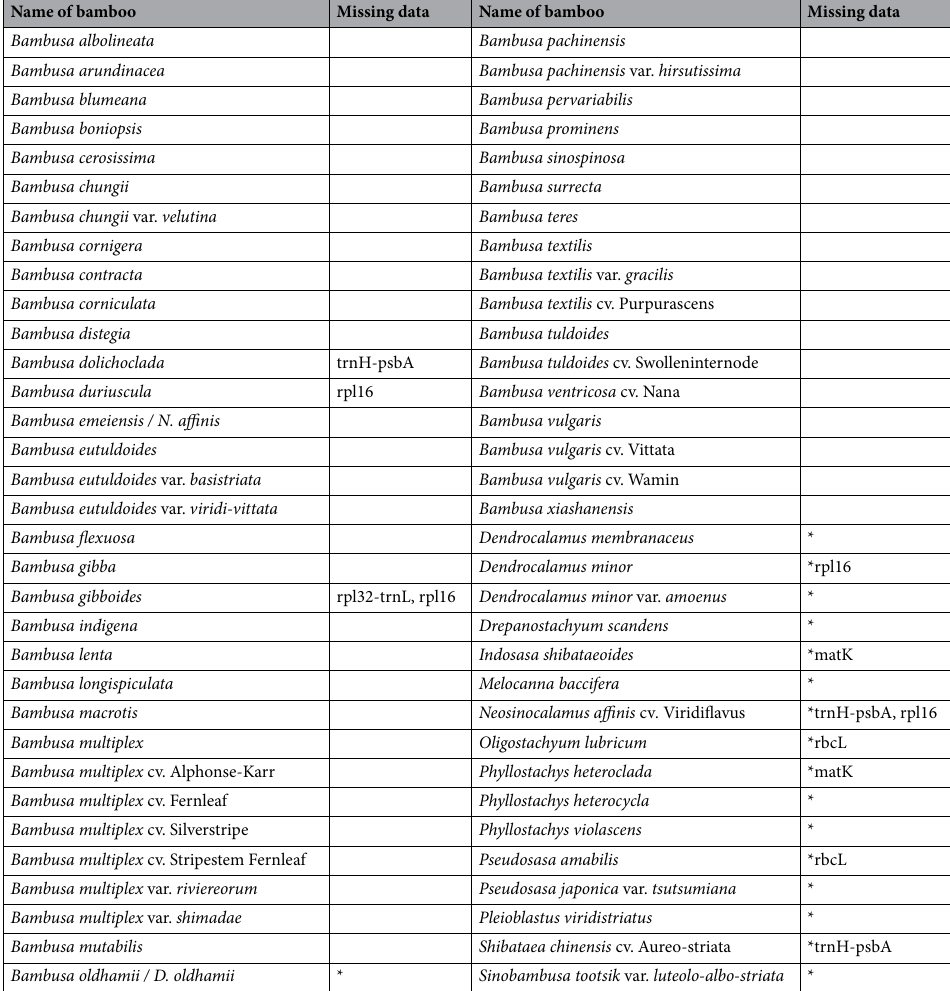
Table 1. Sixty-six taxa from Bambusa and the outgroup. Marker name in the missing data column indicates that there was an amplification or sequencing failure; * indicates missing morphological characteristic data.